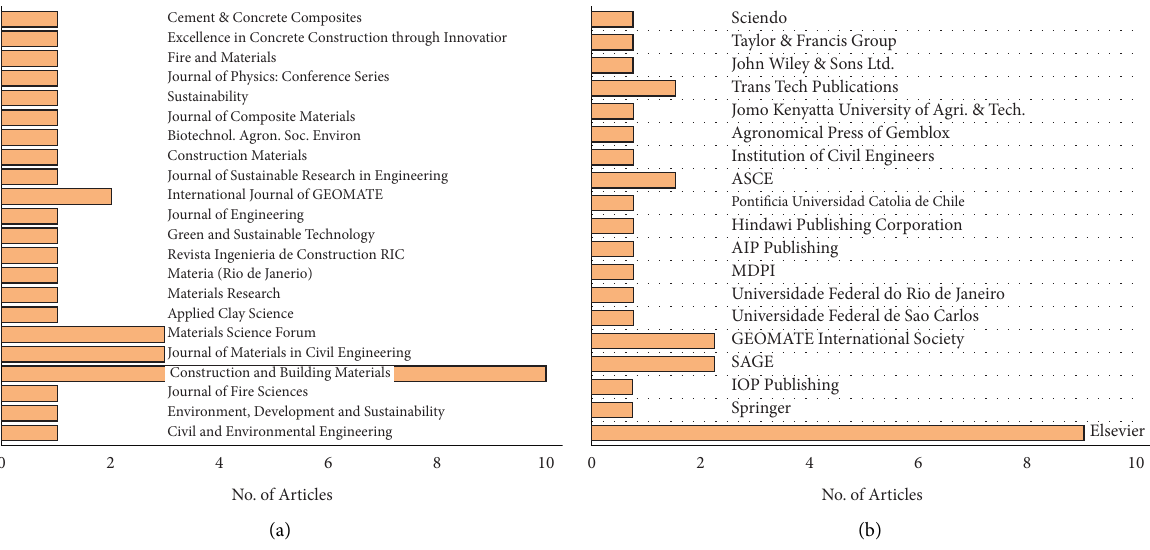
Figure 3: Number of relevant articles ( n � 36) by (a) journals and (b) publishers.